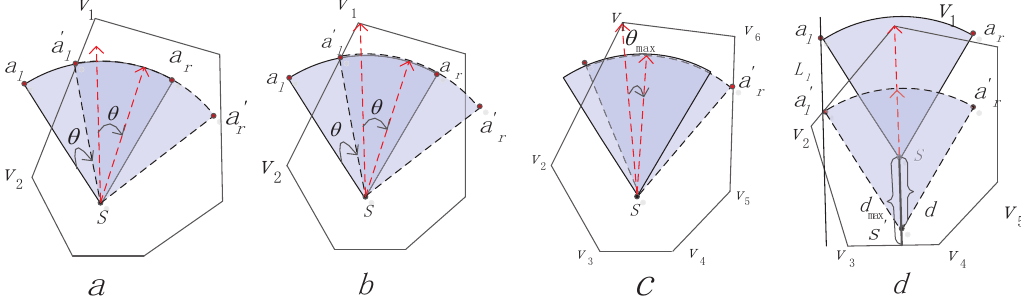
Figure 4. Move and rotate inside the cell. ( a ) rotate; ( b ) rotate a r leads a (cid:48) r ; ( c ) compute the θ max ; ( d ) compute d max and d